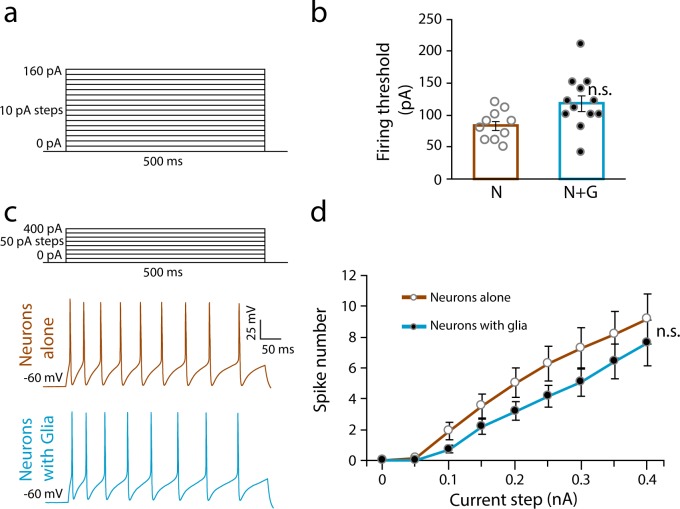
Satellite glial cells do not alter neuronal intrinsic excitability.(a) Illustration of the stimulus pattern applied to determine neuronal firing threshold. (b) Quantification of neuronal firing threshold between neurons alone (N) and neurons co-cultured with glia for 14 days (N+G) conditions. (Unpaired t-test, n ≥ 10 cells, n.s. not statistically different). (c) Illustration of the stimulus pattern applied to evoke action potential firing and representative neuronal traces in response to 400 pA current pulse for neurons grown for 14 days alone (brown, upper trace) or in the presence of glia (blue, lower trace). (d) Average number of action potentials evoked by current steps of increasing amplitude. (n≥16 cells, Mann-Whitney U test pairwise comparison for 400 pA current step, n.s. not statistically different). Results are represented as mean ± s.e.m.